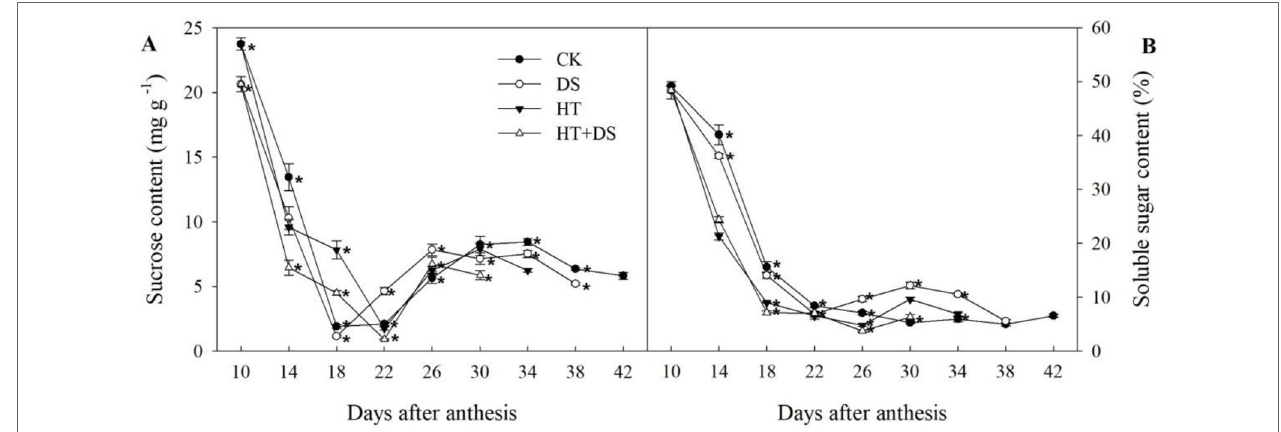
FIGUrE 4 | Dynamic changes in the contents of sucrose (A) and soluble sugars (B) in wheat grains from 10 to 42 days after anthesis in response to temperature and drought stress treatments. Filled circles, control (CK); open circles, drought treatment (DS); filled triangles, high temperature treatment (HT); open triangles, HT+DS treatment. Asterisks (*) indicate significant differences (p 0.05) between the individual treatments (CK, DS, HT, HT+DS).